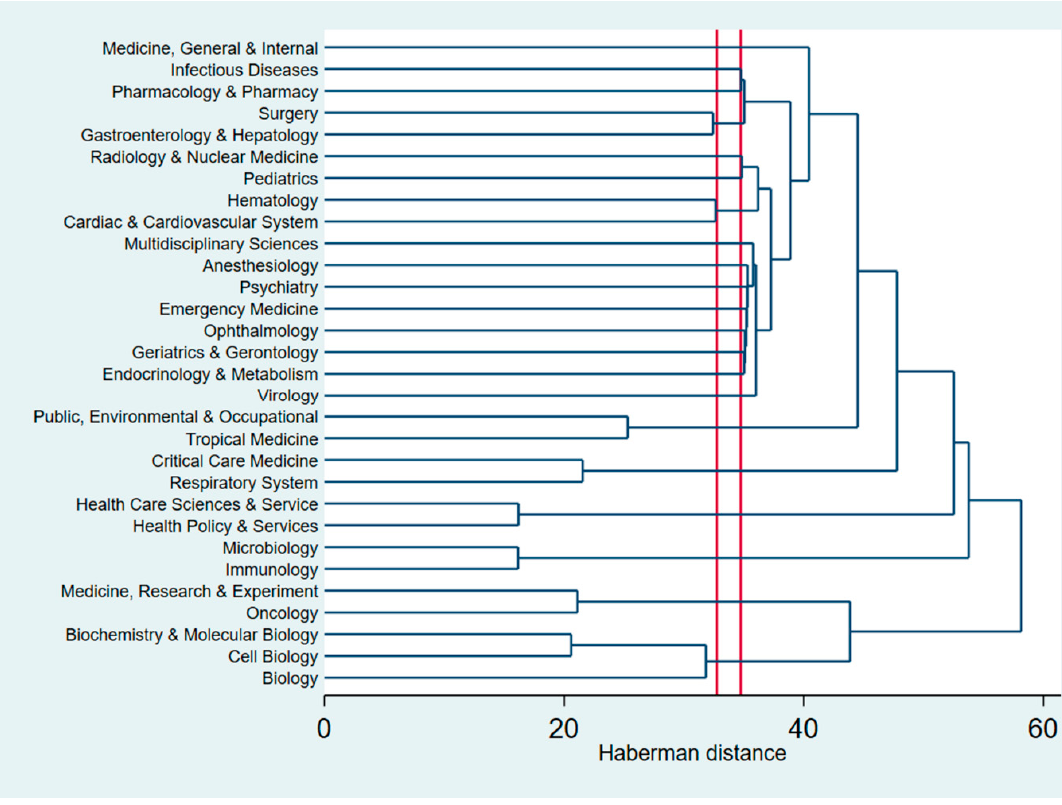
Figure 5. Dendrogram of research areas in WOS database.